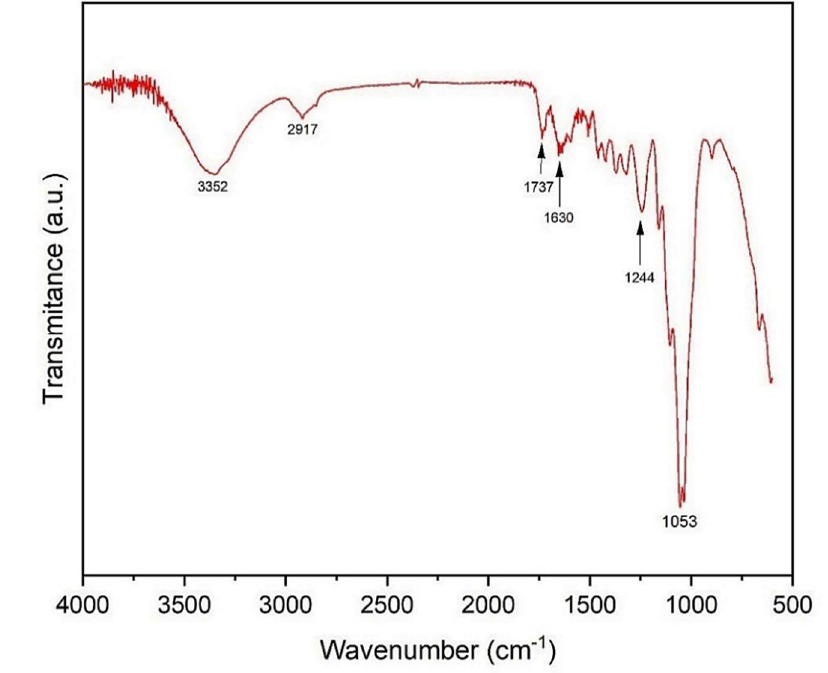
Figure 6. FTIR spectra of kenaf fiber.